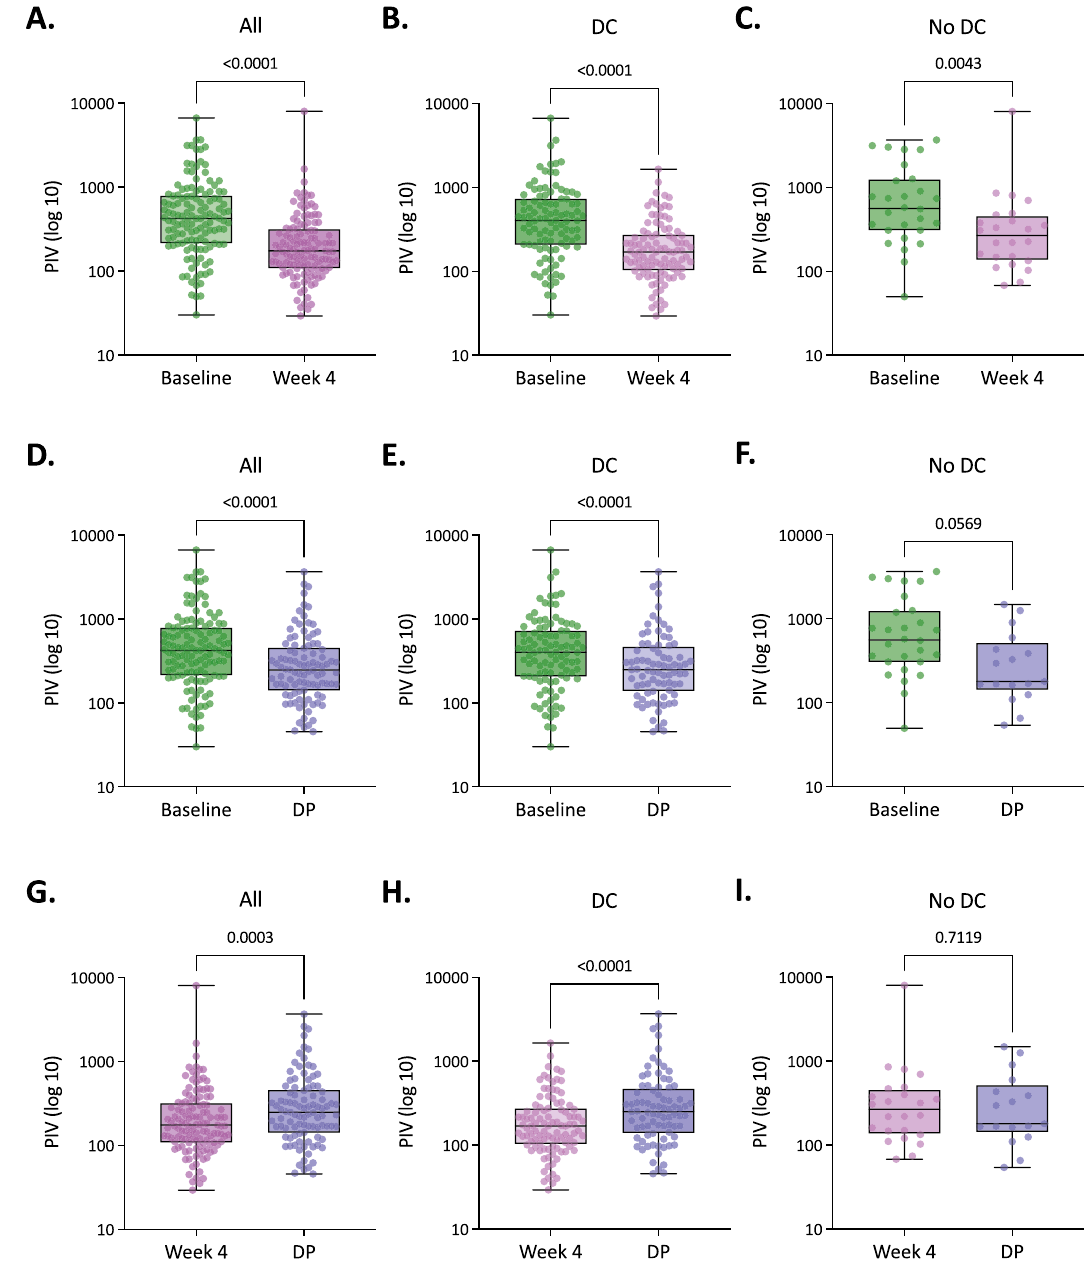
Figure 2. PIV dynamics in patients with metastatic colorectal cancer (mCRC). ( A ) Comparison of PIV at baseline and week 4 from all CRC patients. ( B ) Comparison of PIV at baseline and week 4 from mCRC patients with disease control (DC). ( C ) Comparison of PIV at baseline and week 4 from mCRC patients with no DC. ( D ) Comparison of PIV at baseline and disease progression (DP) from all CRC patients. ( E ) Comparison of PIV at baseline and DP from mCRC patients with DC. ( F ) Comparison of PIV at baseline and DP from mCRC patients with no DC. ( G ) Comparison of PIV at week 4 and DP from all mCRC patients. ( H ) Comparison of PIV at week 4 and DP from mCRC patients with DC. ( I ) Comparison of PIV at week 4 and DP from mCRC patients with no DC. The y -axis (log10 scale) represents PIV values. Boxes represent the interquartile range, and the horizontal line across each box indicates the median value. Whiskers indicate variability outside the upper and lower quartiles, and horizontal lines indicate maximum and minimum values. Statistically significant differences were determined using the Wilcoxon matched-pairs signed rank